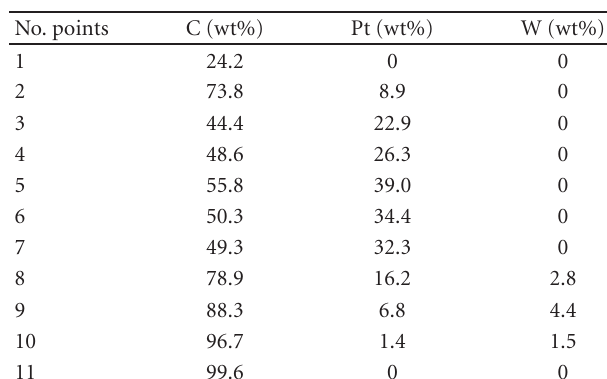
Table 1: Hybrid nanowire material component analysis from EDS